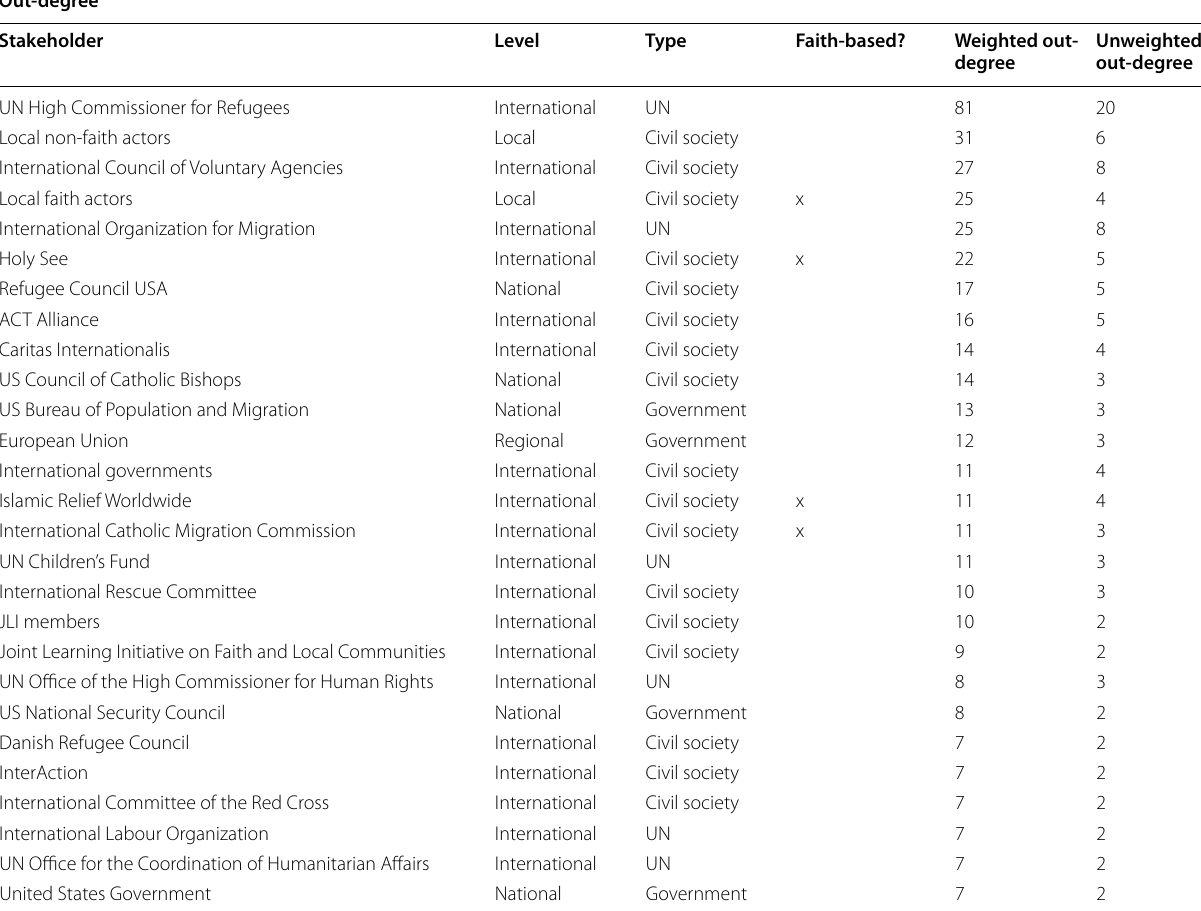
Table 3 The out‑degree centralities of identified stakeholders, ordered by weighted out‑degree